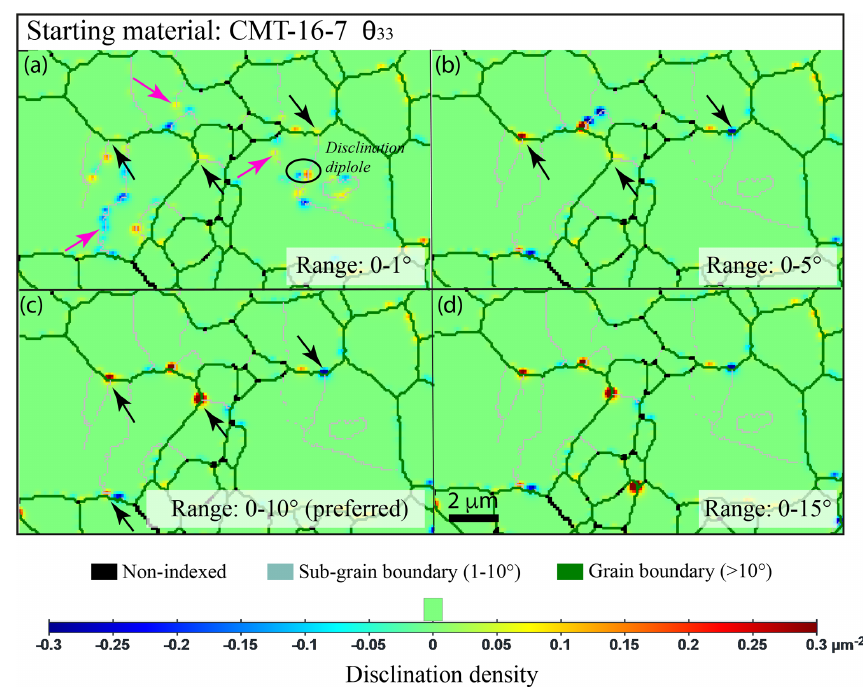
Figure 3. Comparison of wedge disclination densities θ 33 with a different range of disorientation for disclination detection for the selected area (left edge) of the starting-material map (sample CMT-16-7). A user-defined scale was used here; the step size was 0.1µm, and the smoothing factor was 2. Black arrows indicate disclination at triple junctions or grain boundary–sub-grain boundary junctions, and the pink arrows indicate disclination at the intragranular tip of sub-grain